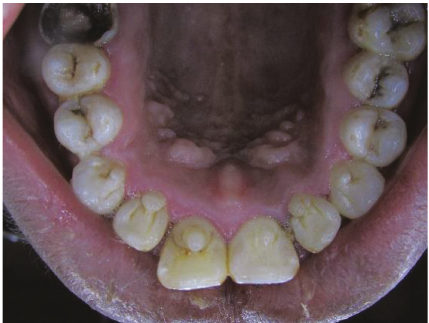
Figure 10: Case 3: palatal view shows talon cusps in all upper anterior teeth.